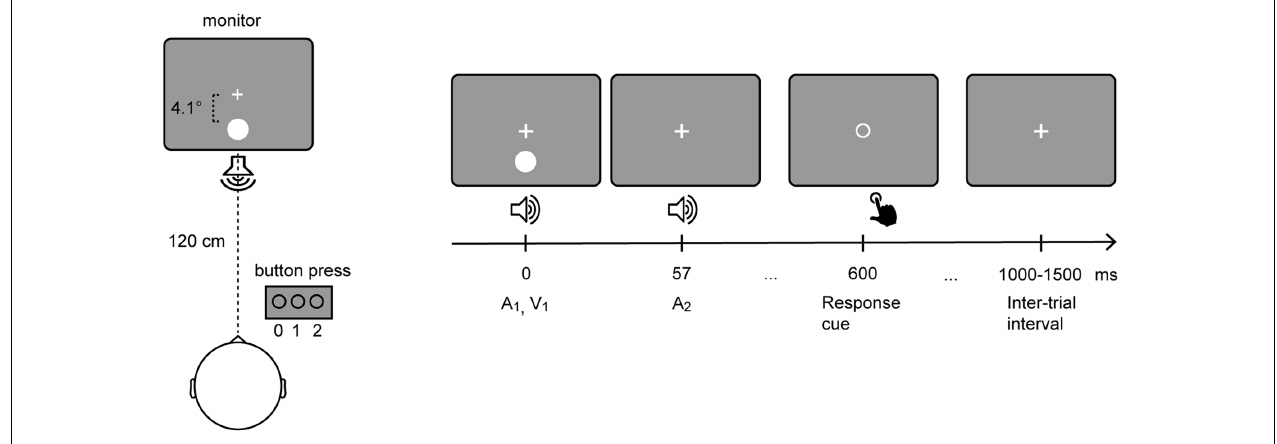
FIGURE 1 | Setup of the sound-induced flash illusion paradigm. Participants fixated a central white cross while being presented with stimuli of the SIFI paradigm ( Left ). In a critical SIFI trial (i.e., A 2 V 1 ) a single flash presented alongside two rapidly repeating tones is either perceived as one or two flashes. ( Right ) depicts the timeline of the critical SIFI trial. The visual stimulus and the first auditory stimulus are presented simultaneously. The second auditory stimulus is presented 57 ms after the onset of the first stimulus. Six hundred milliseconds after the onset of the first stimulus, the fixation cross is replaced by a response cue, which comprised an empty circle that is presented in the center of the